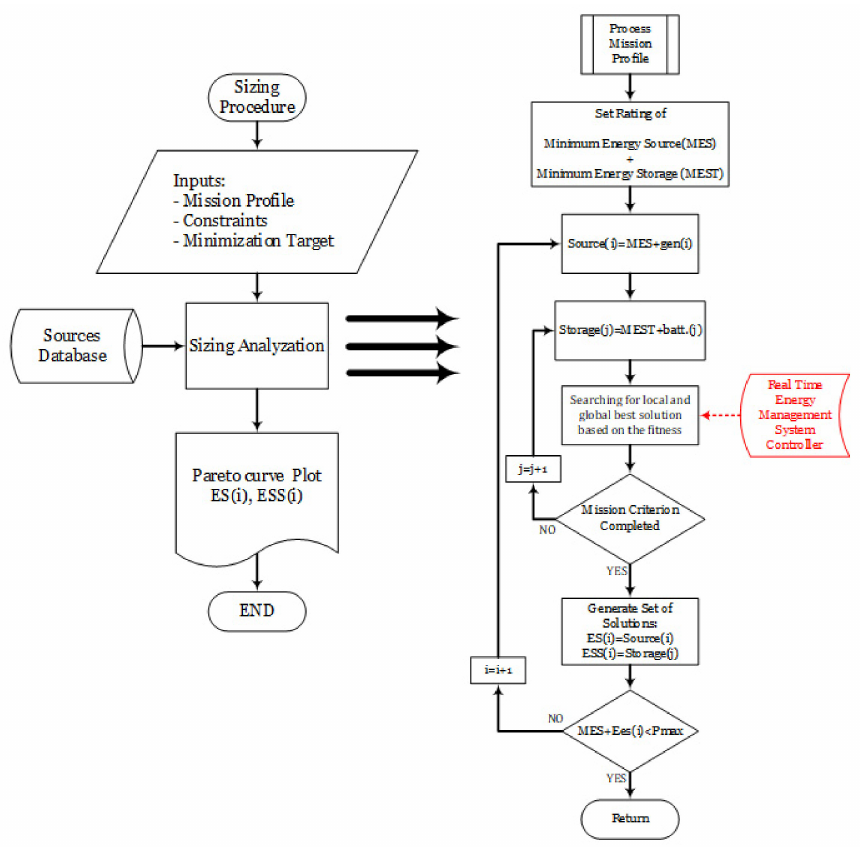
Figure 7. Generic sizing